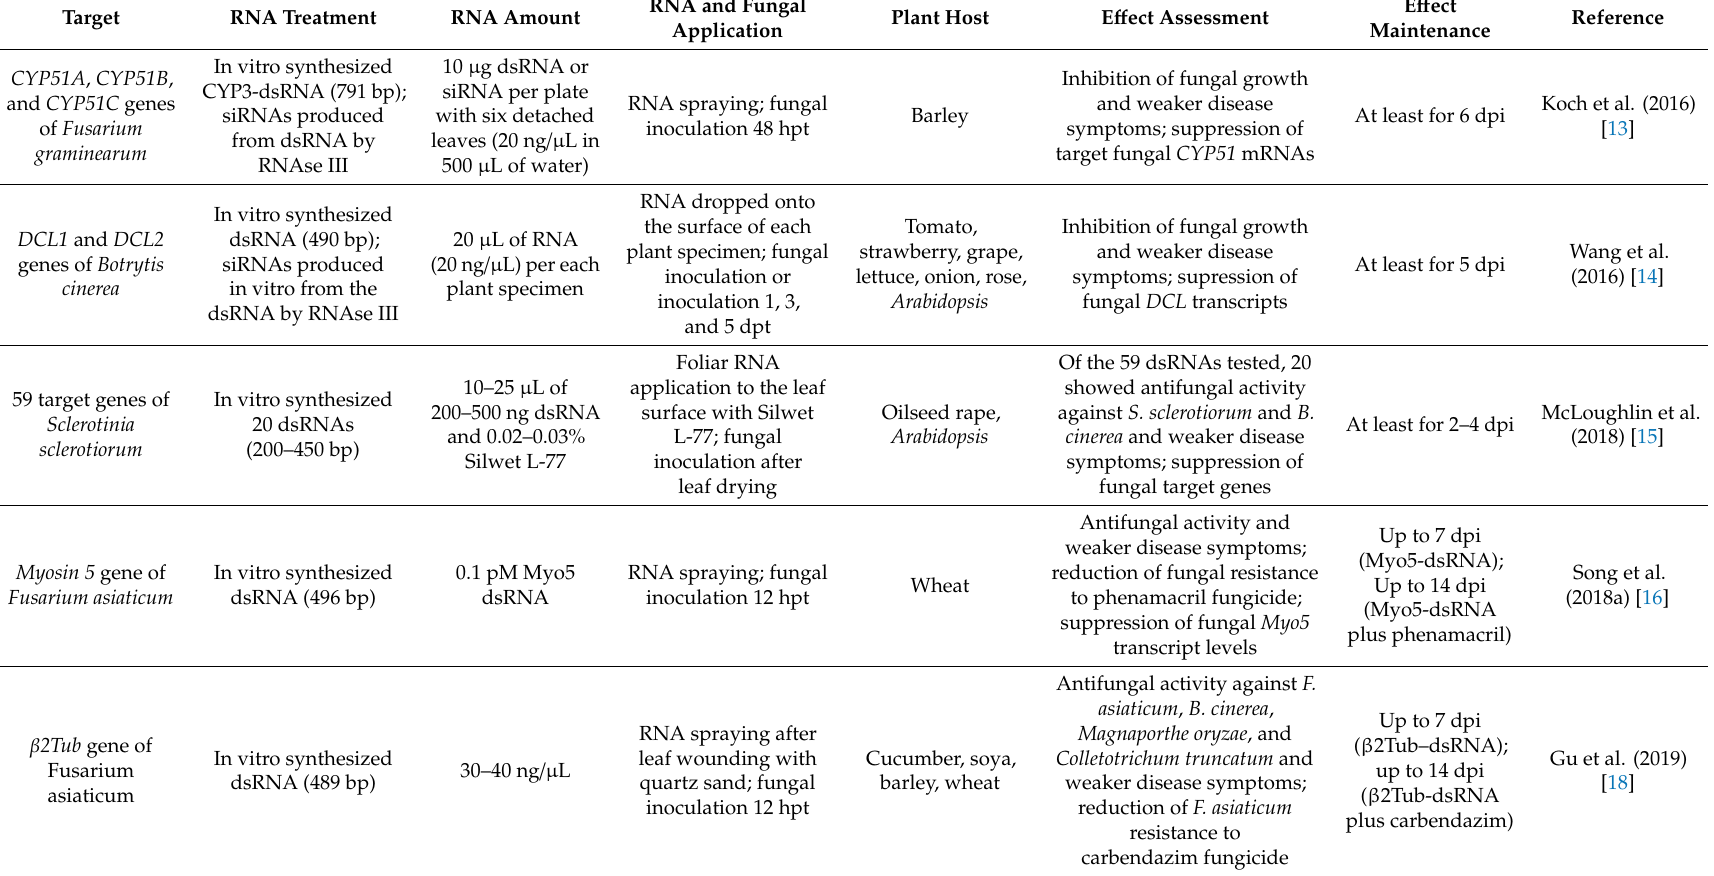
Table 3. Application of external RNAs for plant fungal